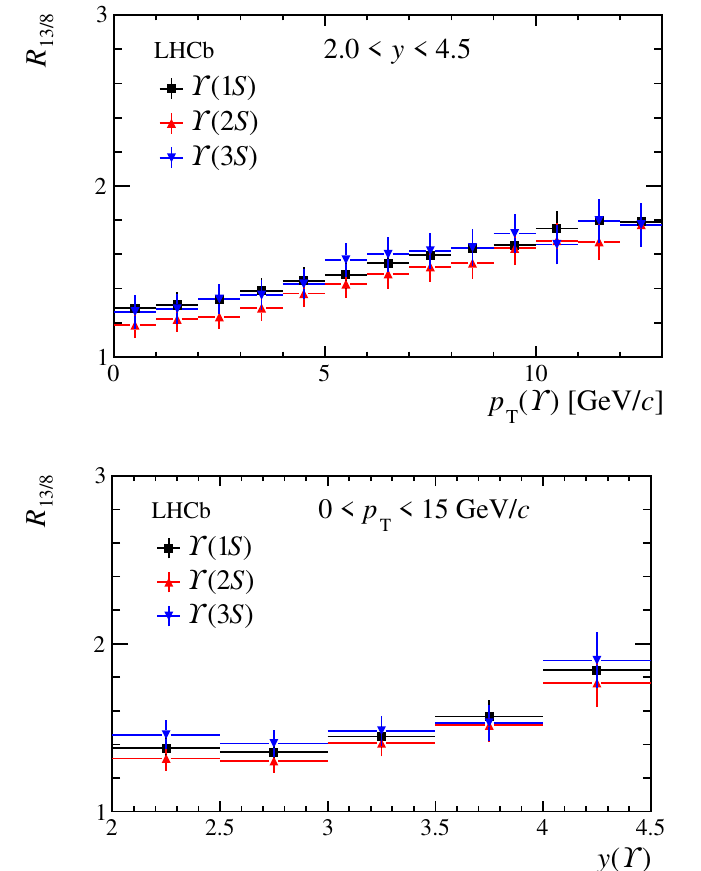
Figure 7 . Ratios of di(cid:11)erential cross-sections between 13 TeV and 8 TeV measurements (top) versus p T integrated over y and (bottom) versus y integrated over p T for the (cid:7) (1 S ) (black solid squares), (cid:7) (2 S ) (red upward triangles) and (cid:7) (3 S ) (blue downward triangles) states. Statistical and systematic uncertainties are added in